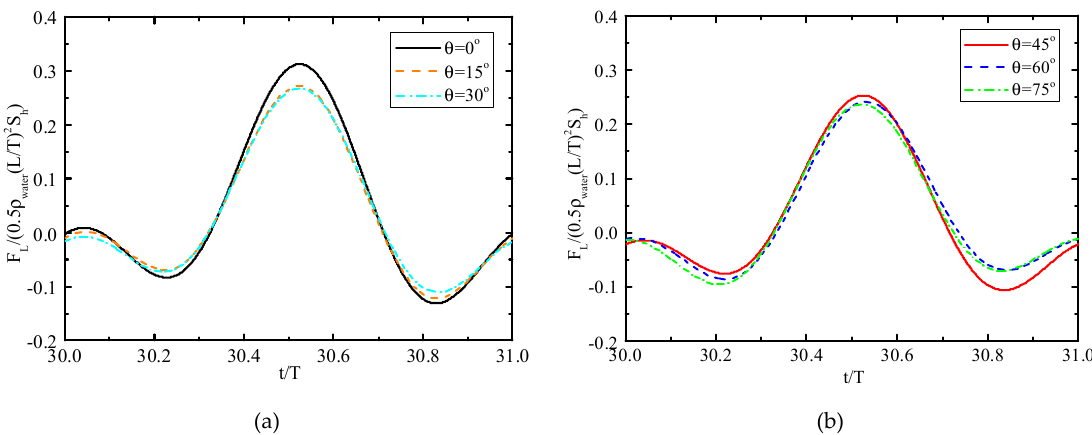
Figure 12. Variation of the normalized low-order wave forces on the cylinder in different transverse inclined angles.( a )